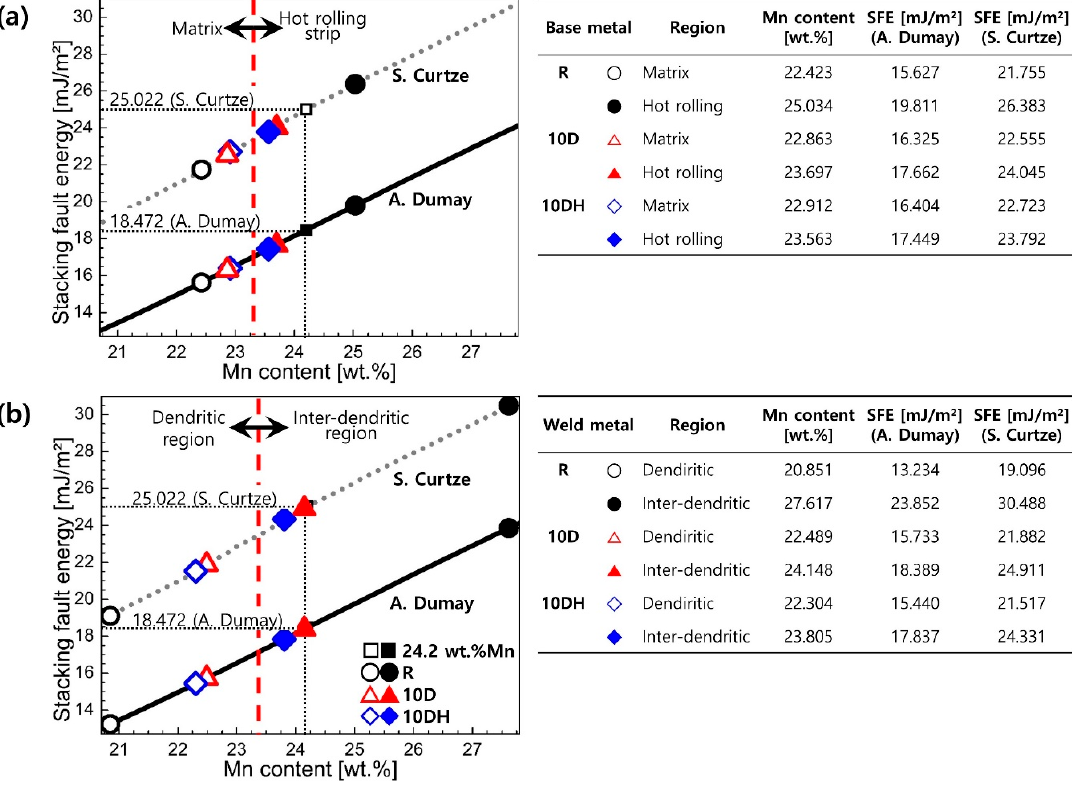
Figure 5. Stacking fault energy calculation in the ( a ) base metal and ( b ) weld metal of each pipe. The models were suggested by Dumay et al. [29] and Curtze et al. [30].